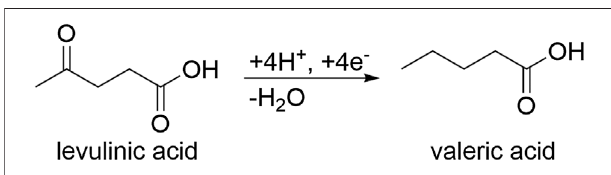
FIGURE 1 | Electrochemical reduction of levulinic acid to valeric